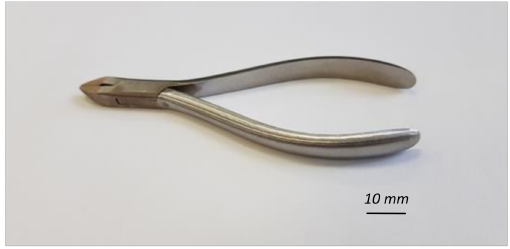
Figure 3. Workpiece—orthodontic